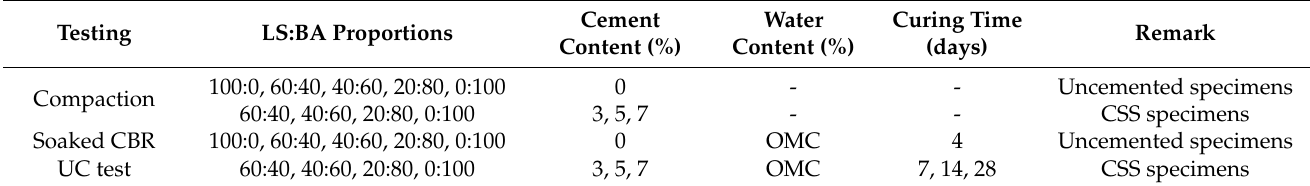
Table 3. Testing